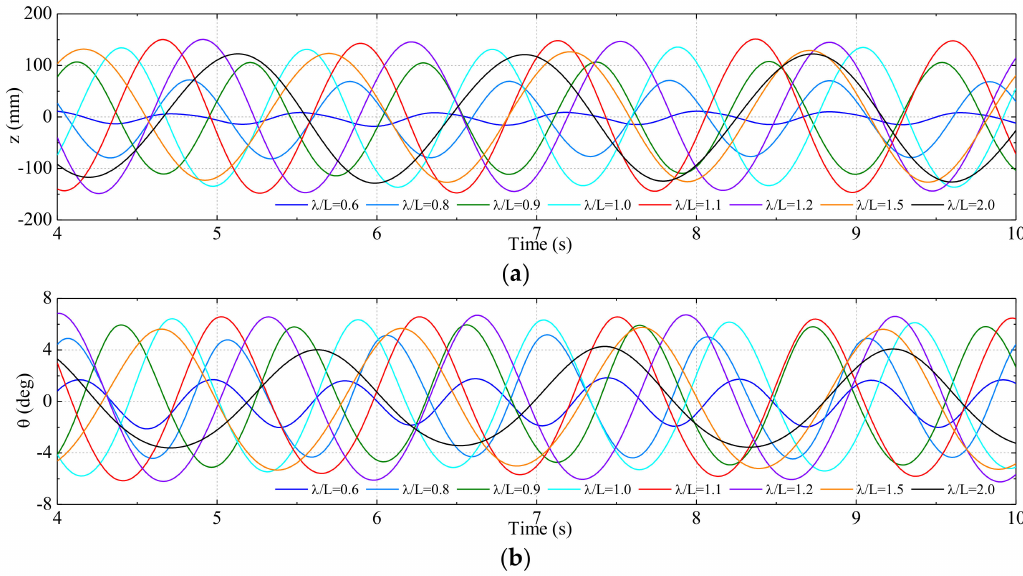
Figure 21. Time series of ship vertical motion at di ff erent wave lengths: ( a ) heave; ( b ) pitch. The amplitude of ship vertical motions in di ff erent wave lengths λ / L = 0.6 − 2.0 at the wave